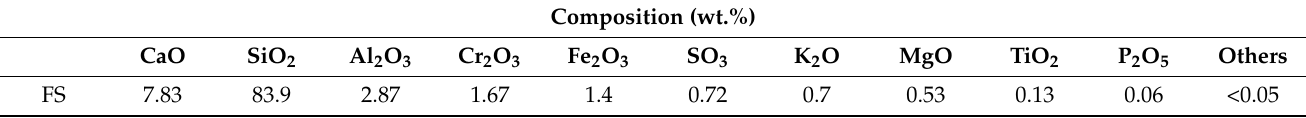
Table 3. UFS chemical composition.